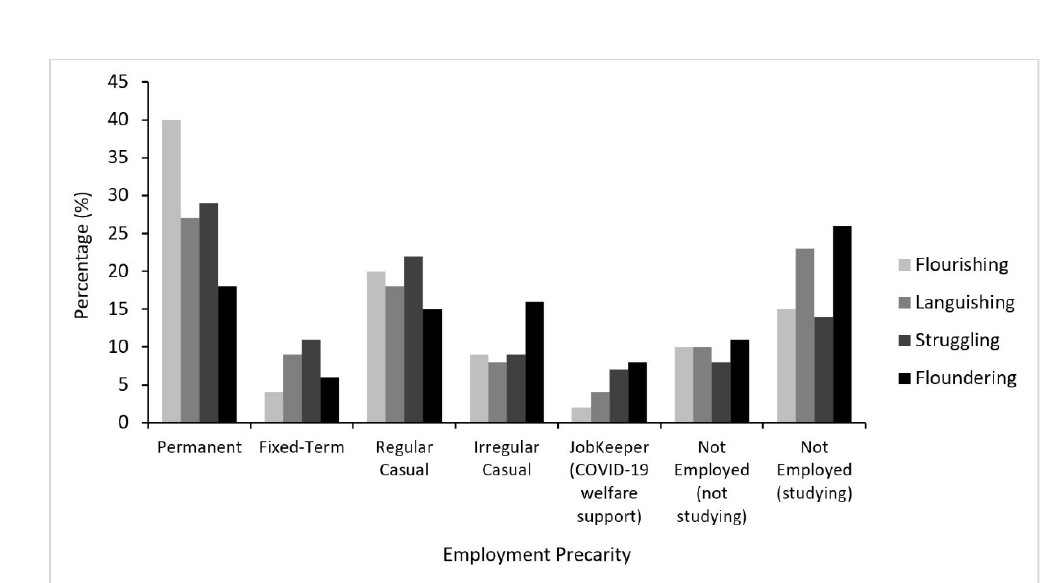
Figure 2. Employment precarity by mental health state during the COVID-19 pandemic.